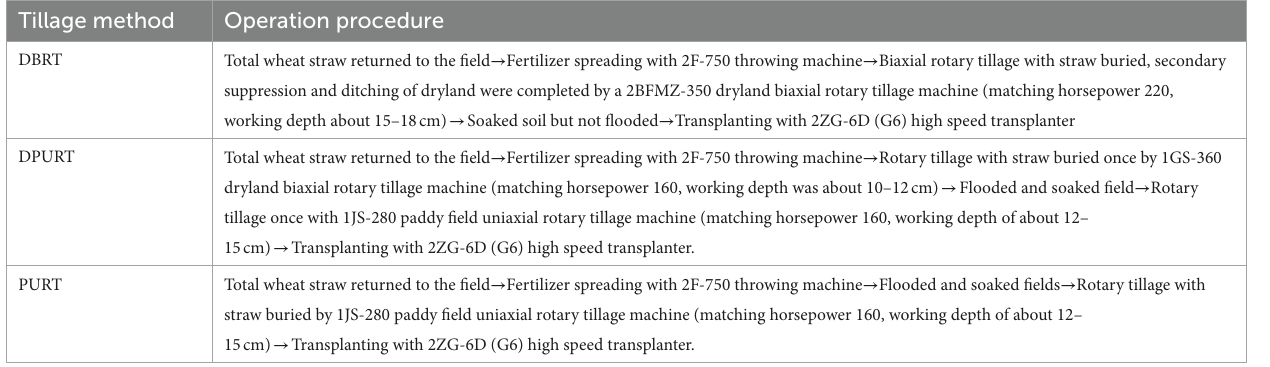
TABLE 2 Operation procedures and the equipment used of three tillage